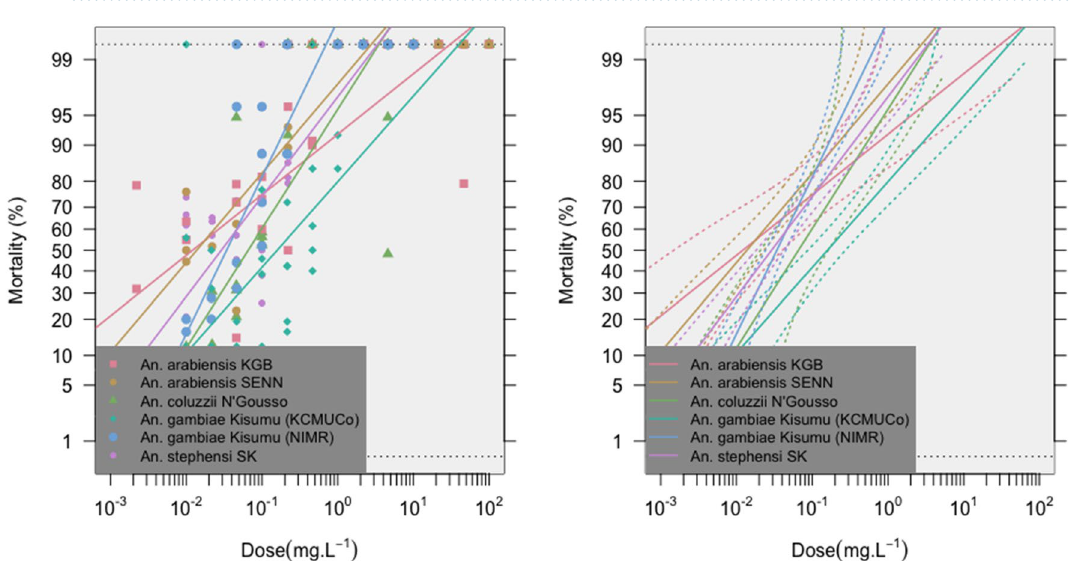
Figure 2. Linear relationships between probit-transformed mortality rates and log-dose of broflanilide for different Anopheles insectary strains (left), with 95% confidence intervals